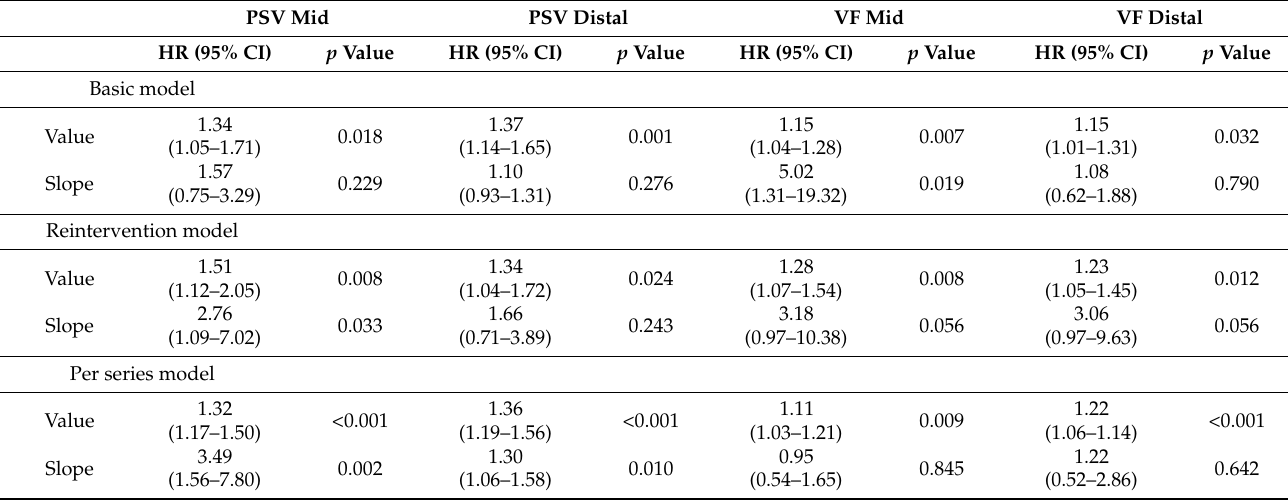
Table 2. Association between duplex values and stenosis or occlusion as estimated by the three different